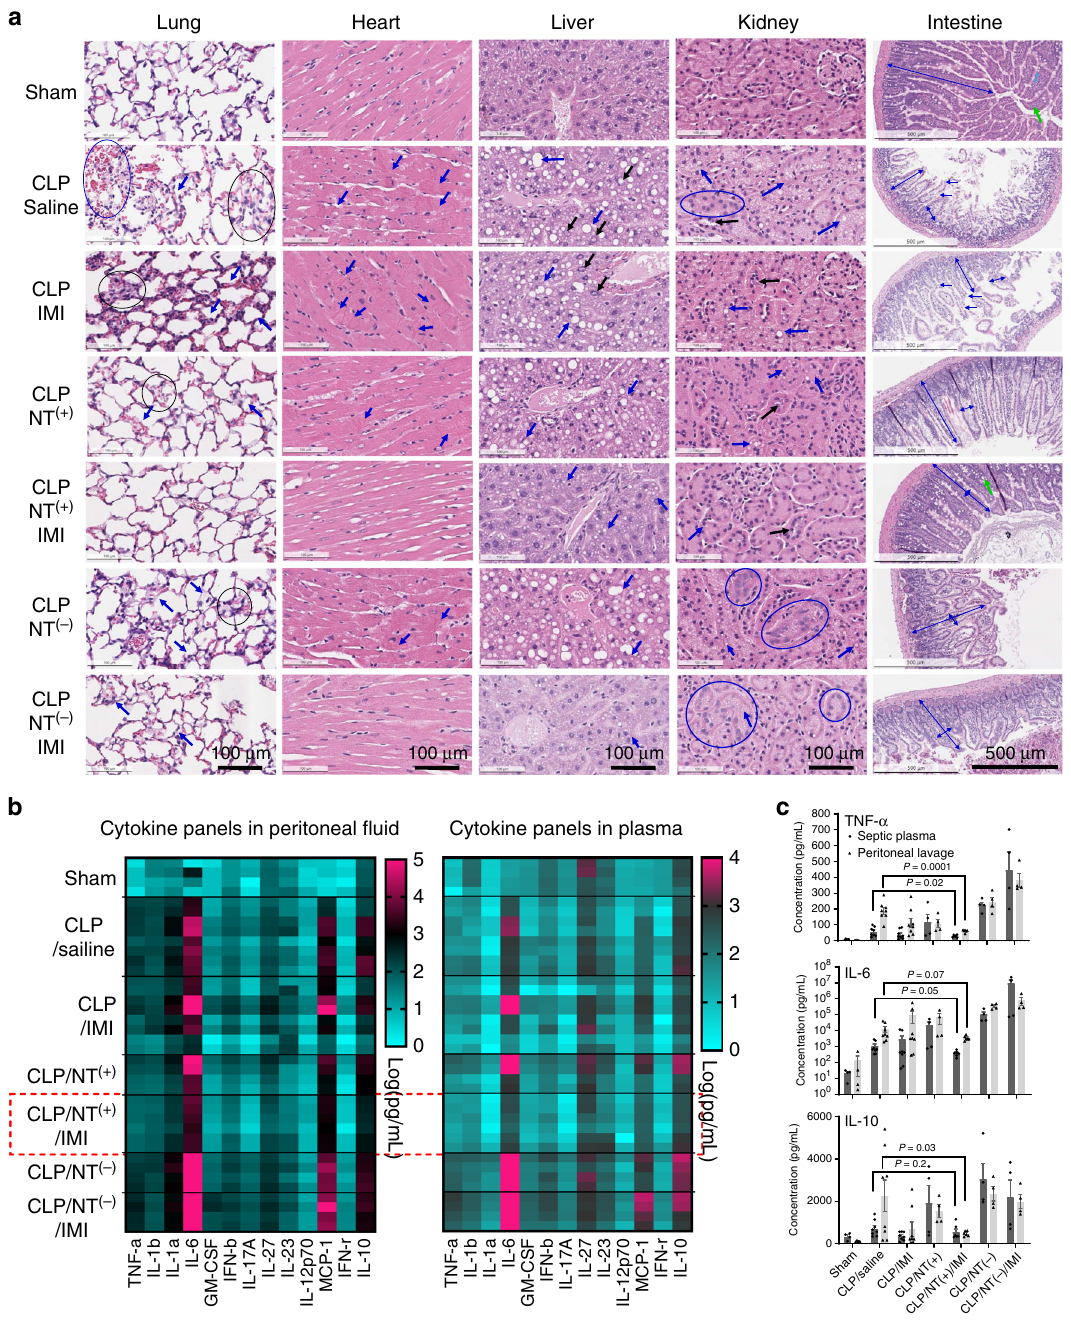
Fig. 7 Reduced tissue damage and attenuated hyperin fl ammation in severe sepsis. a Tissue histology ( n = 2) stained with hematoxylin and eosin for major organs of septic mice with the most severe hypothermia at 24 h post CLP in different groups. Histopathological fi ndings: Lung: alveolar congestion (black circle), hemorrhage (blue circle), alveolar thickening, and hyaline membrane formation (arrow); Heart: intracellular edema and contraction bands (arrow), indicating early cell death; Liver: predominantly macrovascular steatosis (blue arrow) and nuclear inclusion (black arrow); Kidney: proximal tubular edema and vacuolization (blue arrow), luminal epithelial desquamation (black arrow), and epithelial nuclear enlargement (circle); Intestine: villous shortening, villous edema, villous necrosis (blue arrow), and loss of goblet cells (green arrow). b The heatmap of multiple in fl ammatory cytokine pro fi les, and c quantitative analysis of key cytokines (IL-6, TNF- α , IL-1 β , and MCP-1) in both plasma and peritoneal lavage fl uids in mice at 24 h post CLP in different treatment groups in comparison with sham mice ( n = 4, mean ± SEM. Statistical signi fi cance was measured by unpaired one-sided Student ’ s test). Source data are available in the Source Data fi